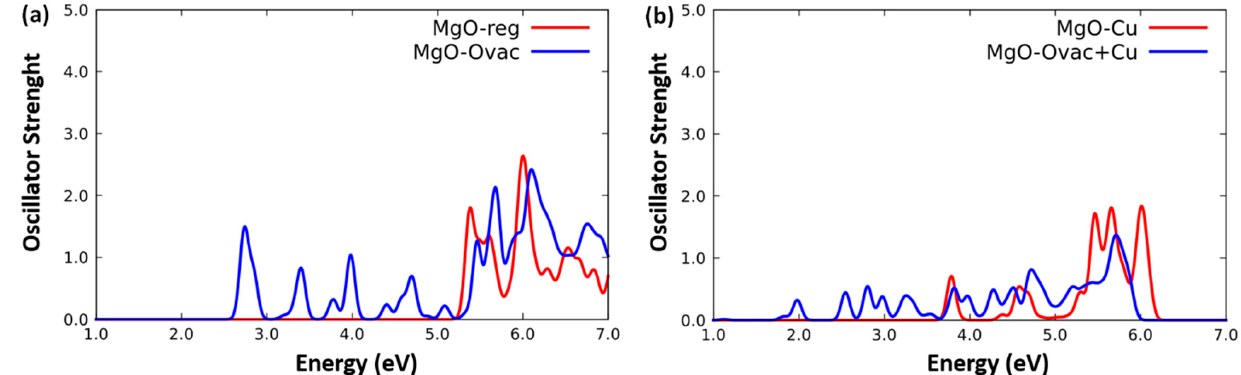
Figure 2. Simulated TDDFT/PBE0 photo-absorption spectra of: ( a ) MgO(100)-reg and MgO(100)-Ovac, and ( b ) MgO(100)- Cu, and MgO(100)-Ovac+Cu using the ORCA code.